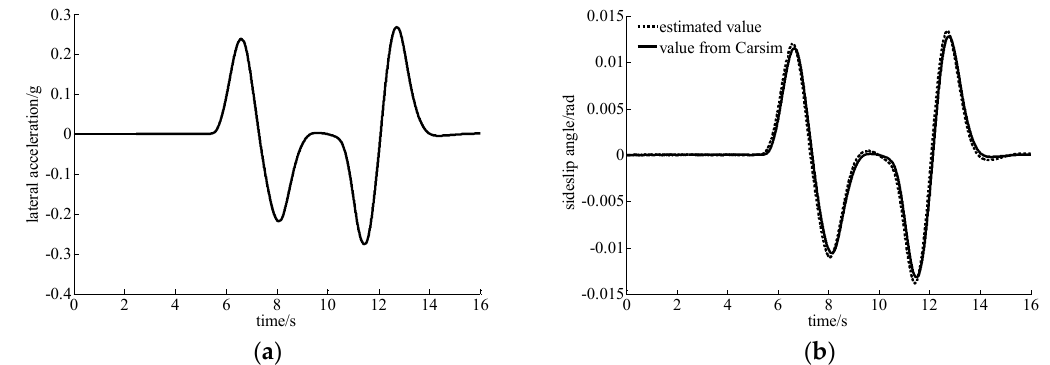
Figure 6. Estimation for sideslip angle (when V x is 40 km/h and μ is 0.8) ( a ) Lateral acceleration. ( b ) Sideslip angle.